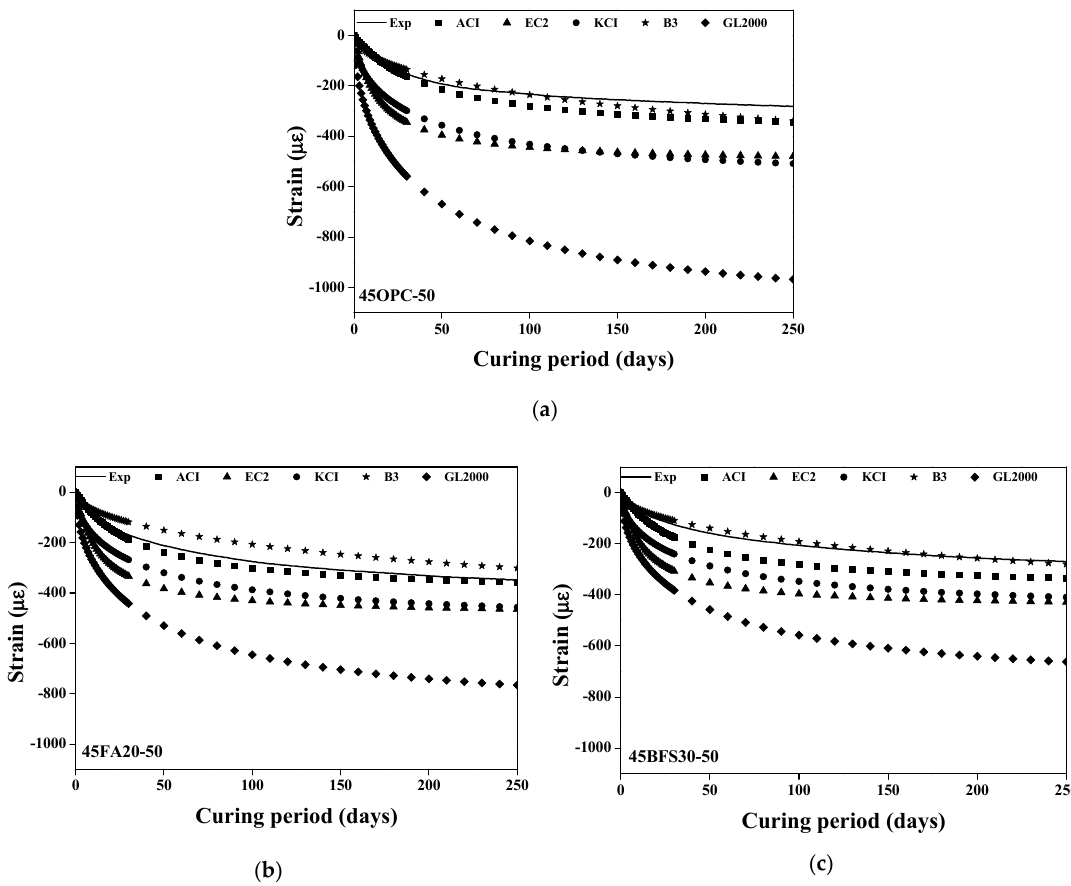
Figure 9. Comparison between test results and predicted value (Steel slag substitution ratio: 50%). ( a ) 45OPC; ( b ) 45FA20; ( c ) 45BFS30.